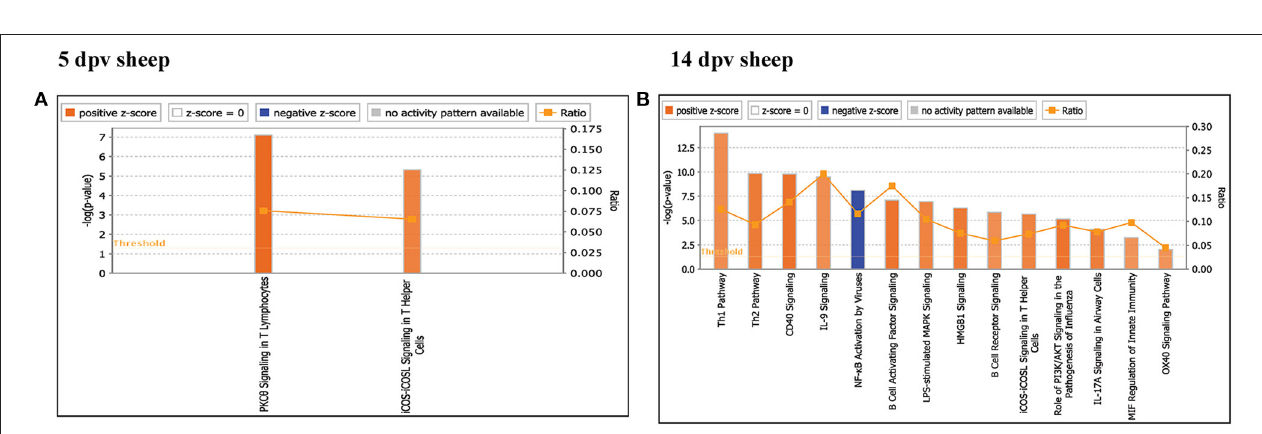
FIGURE 3 | Canonical pathways activated/inactivated in vaccinated goats (A) 5 days post-vaccination (dpv) and (B) 14 dpv were generated in core analysis of the Ingenuity Pathway Analysis (IPA) tool. Red pathways are activated ( > 2), and blue pathways are inactivated ( < 2). Height of the bar graphs indicates -log ( p -value), and the line graph shows the ratio of listed proteins found in each pathway over the total number of proteins in that pathway. The uniport ID of differentially expressed proteins (DEPs) was converted into gene ID, and this list of proteins with corresponding fold change was uploaded in IPA for downstream analysis.